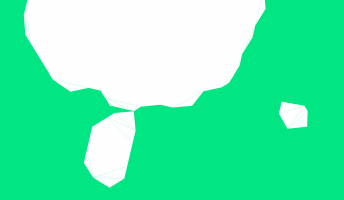
Figure 8: The green filled area is formed by the triangles that be- long to the final triangulation, whereas the wireframe belongs to the raw triangulation, its triangular meshes were deleted because of a side longer than the maximum edge limit.